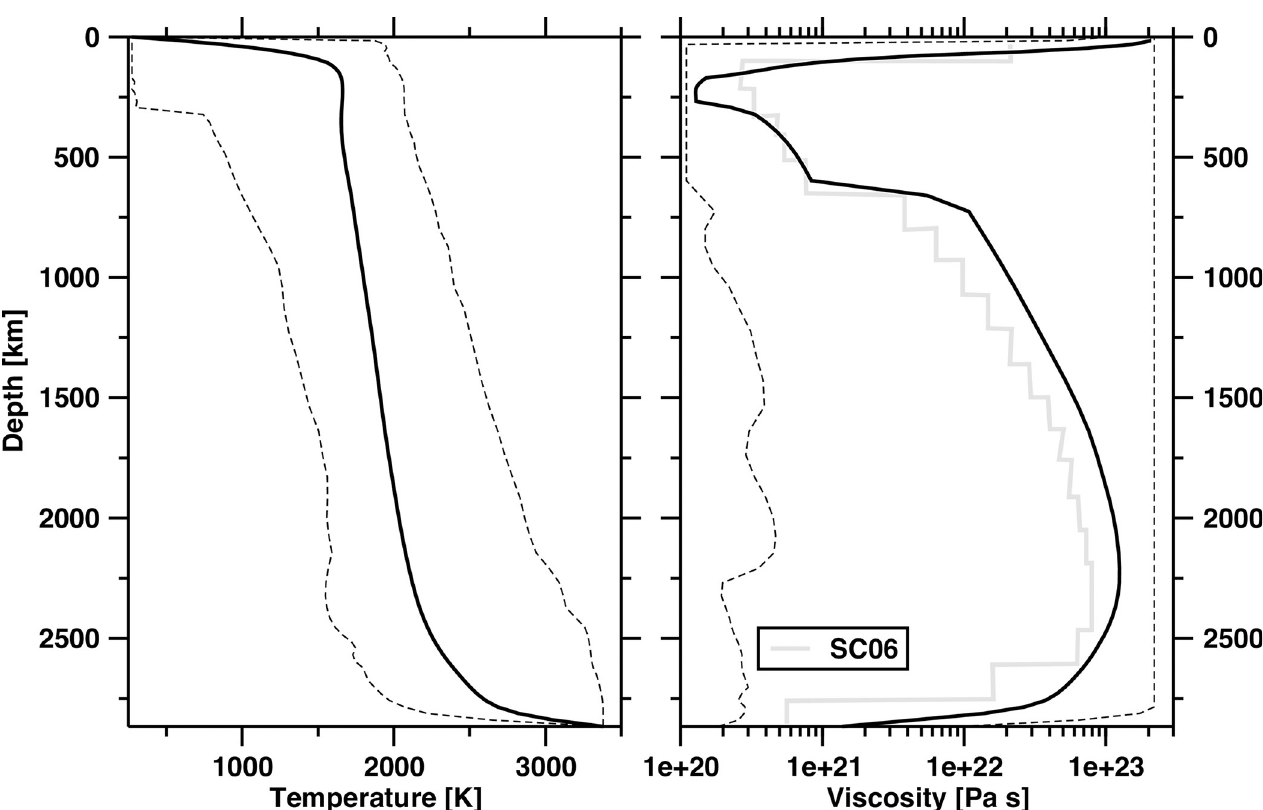
Fig 2. Temperature and viscosity with depth. Horizontally averaged present-day mantle temperature (left-hand side) and viscosity (right-hand side) for Case 2. Solid lines show the average, and dashed lines show the minimum and maximum. The grey line on the right-hand side panel is a viscosity profile adjusted to fit the geoid and post-glacial rebound